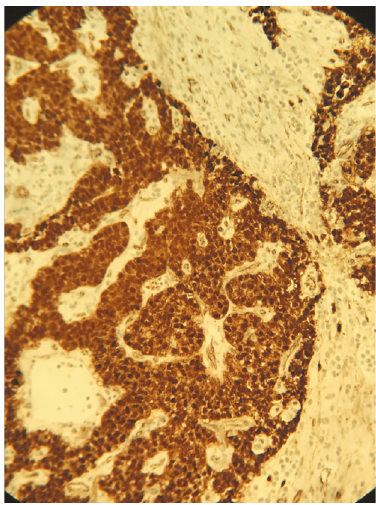
Figure 5: Immunohistochemical staining shows nuclear positivity for beta-catenin in the tumor cells, which is characteristic of SPN.